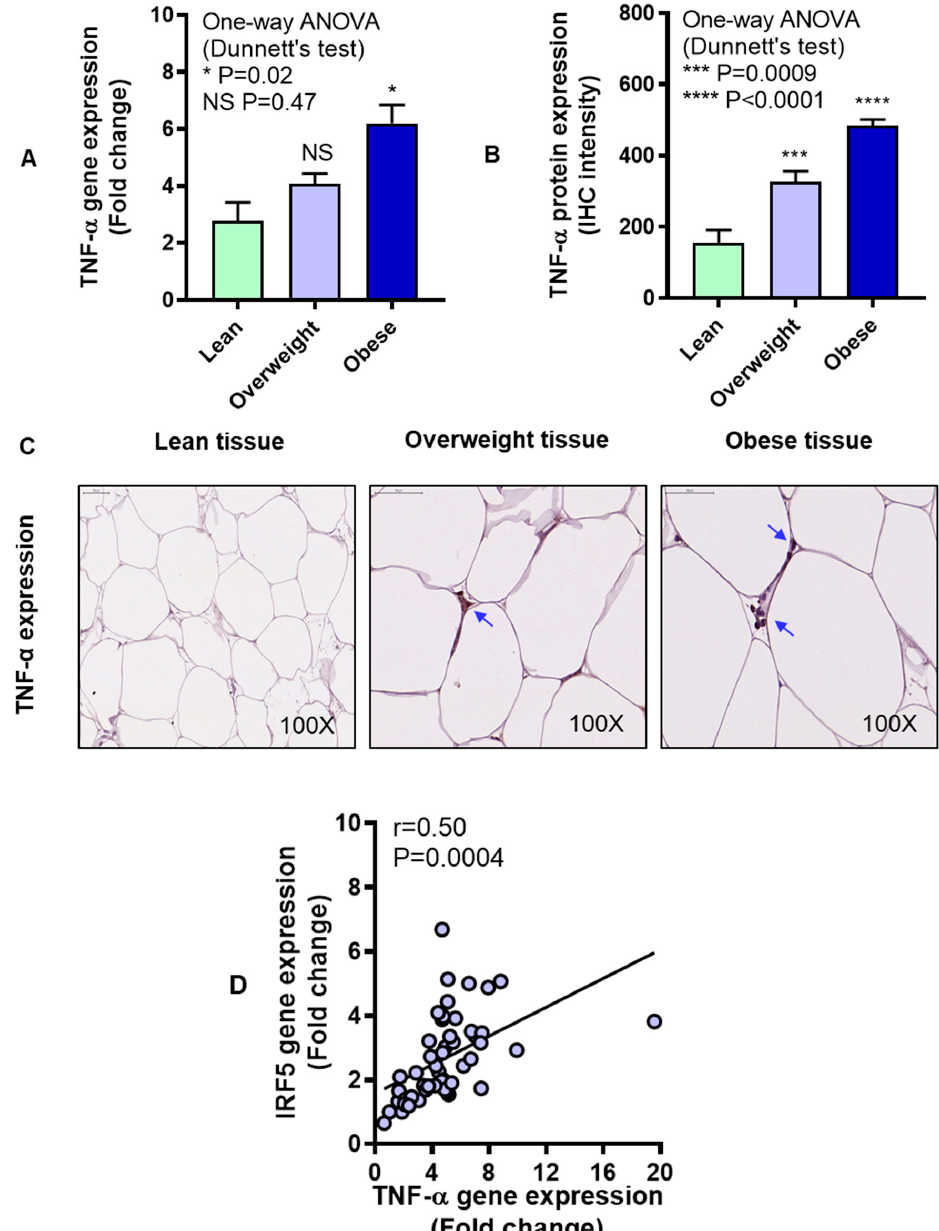
Figure 3. Increased adipose tumor necrosis factor- α (TNF- α ) expression in obesity. Adipose TNF- α gene expression was determined in six lean, 18 overweight, and 27 obese non-diabetic individuals using real-time RT-PCR, while TNF- α protein expression was also determined in five lean, 13 overweight, and 10 obese non-diabetic individuals using immunohistochemistry (IHC) as described in Materials and Methods. The data (mean ± SEM) show that ( A ) TNF- α adipose gene expression was higher in obese (P = 0.02) compared with lean individuals. ( B ) TNF- α protein expression (expressed as IHC intensity in arbitrary units) was also elevated both in overweight (P = 0.0009) and obese (P < 0.0001) compared with lean individuals. ( C ) The representative IHC images obtained from three independent determinations with similar results show increased adipose tissue TNF- α expression (blue arrows, 100 × magnification) in overweight and obese individuals compared with lean. Scale bar = 50 µ M. ( D ) IRF5 and TNF- α gene expression correlated positively in the adipose tissue (r = 0.50, P = 0.0004). The asterisks *, ***, and **** represent significance levels of P ≤ 0.05, P < 0.001, and P < 0.0001,